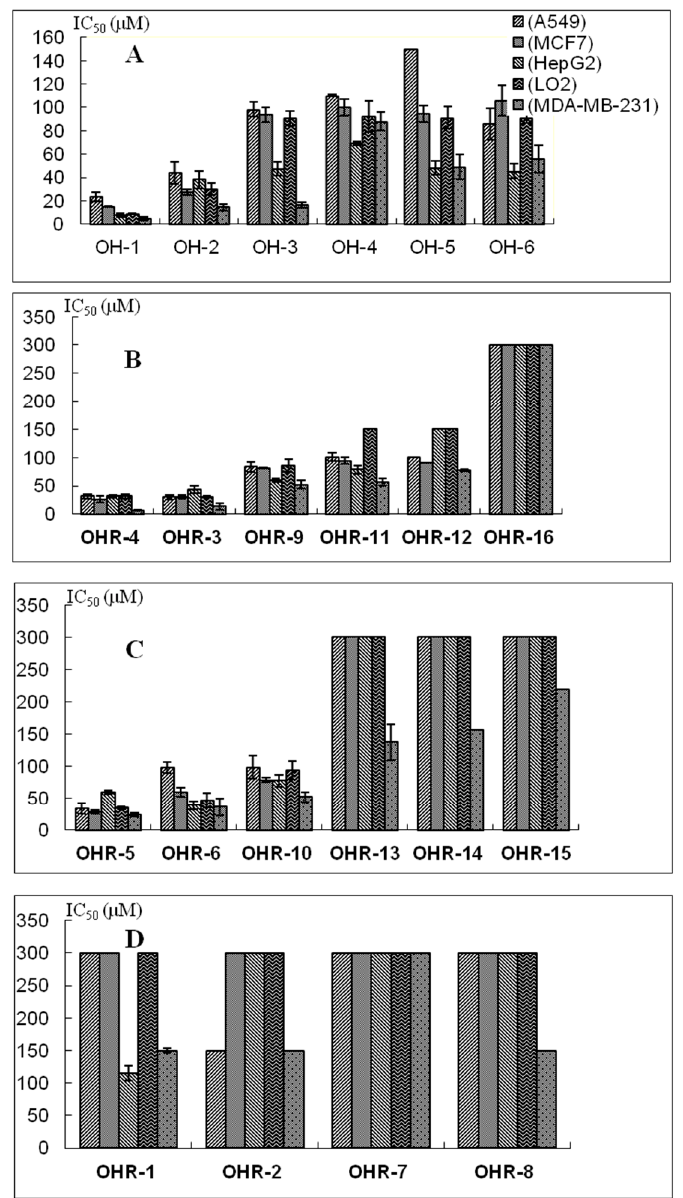
Figure 2. The anti-proliferative effects of the similar polyynes on MCF-7 cells, A549 cells, HepG2 cells and MDA-MB-231 cells. ( A ) all the natural polyynes; ( B ) the polyynes with the hydroxyl in the middle of the carbon chain displaced; ( C ) the polyynes with the hydroxyl near the end of the carbon chain; ( D ) the polyynes with no